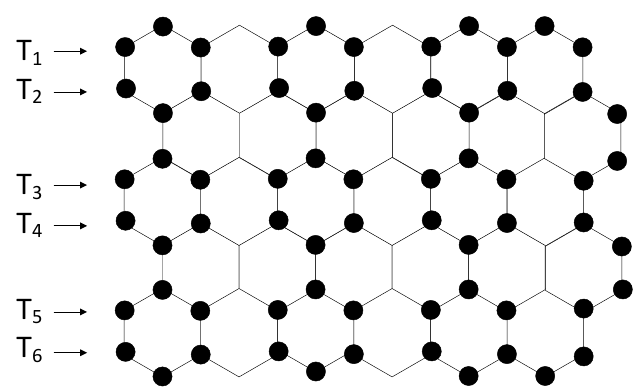
Figure 7. T 1 ∪ T 2 ∪ · · · ∪ T 7 on H 6,6 .